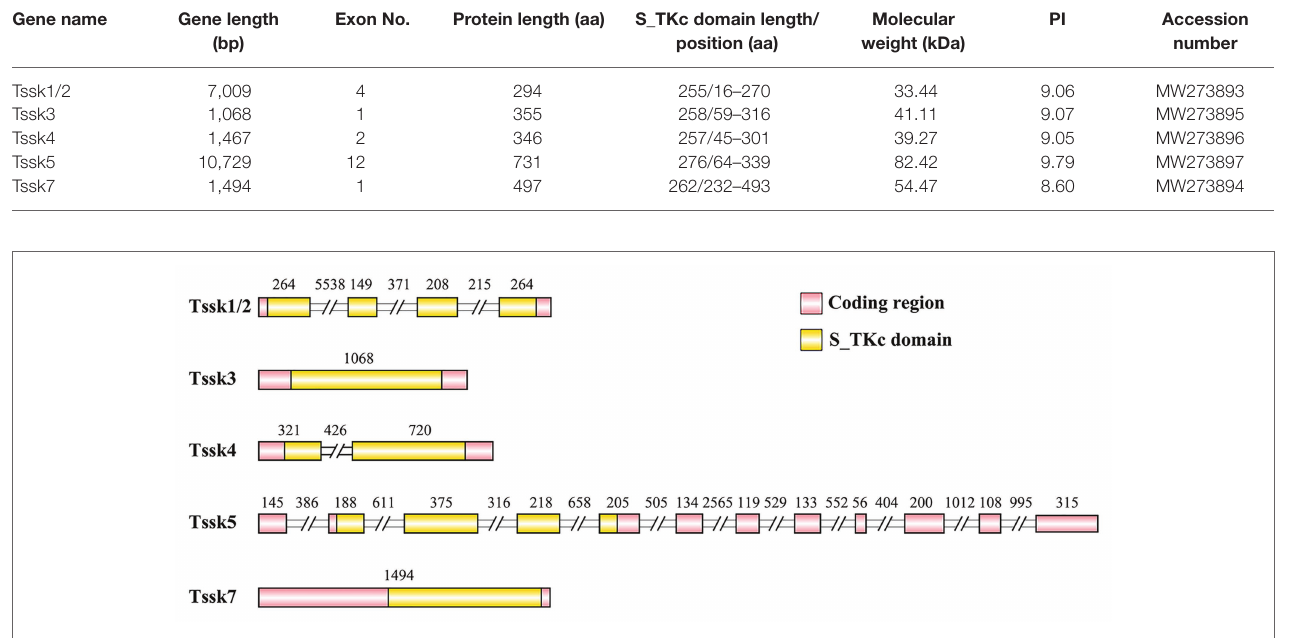
FIGURE 1 | The structure of the Tssk genes of A. irradians . The pink boxes represent the coding regions, and the yellow boxes indicate the S_TKc domains. The diagram is shown according to the sequence length (bp) except for the intron regions that marked with double slash. The numbers indicate the nucleotide length (bp) of the exons or